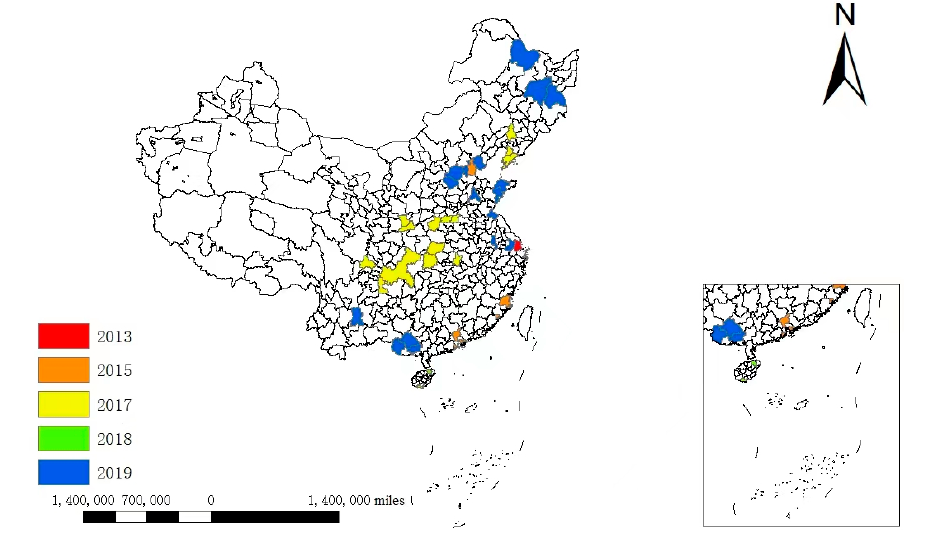
Figure 1. The distribution of the PFTZs from 2013 to 2019. Source: We depict this fi gure according to the o ffi cial authoritative documents. the official authoritative